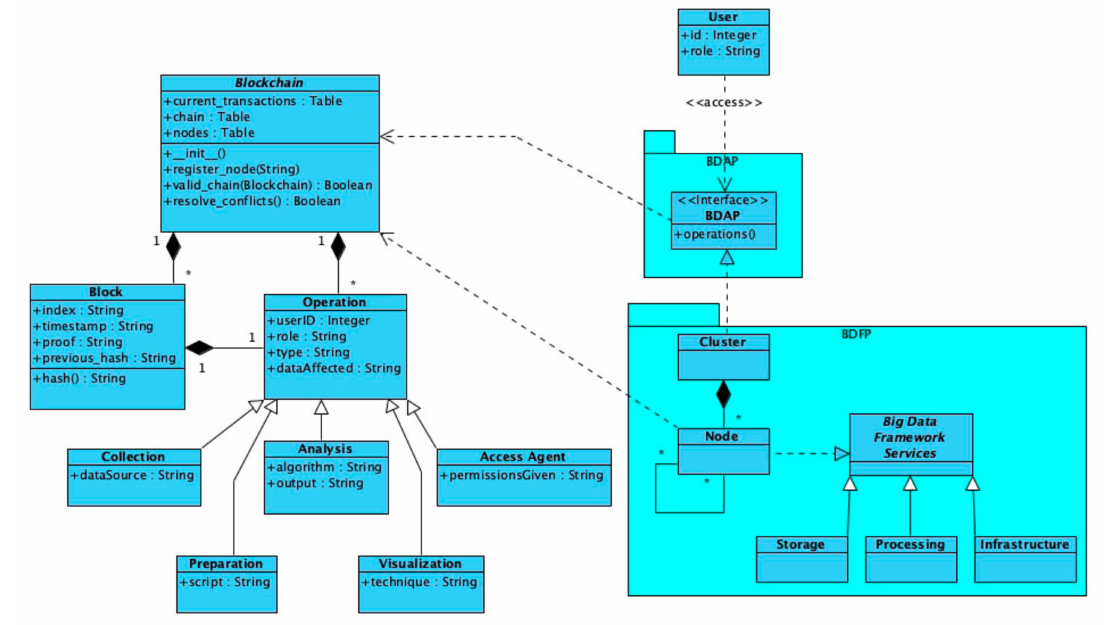
Figure 4. Interaction between big data ecosystems and blockchain